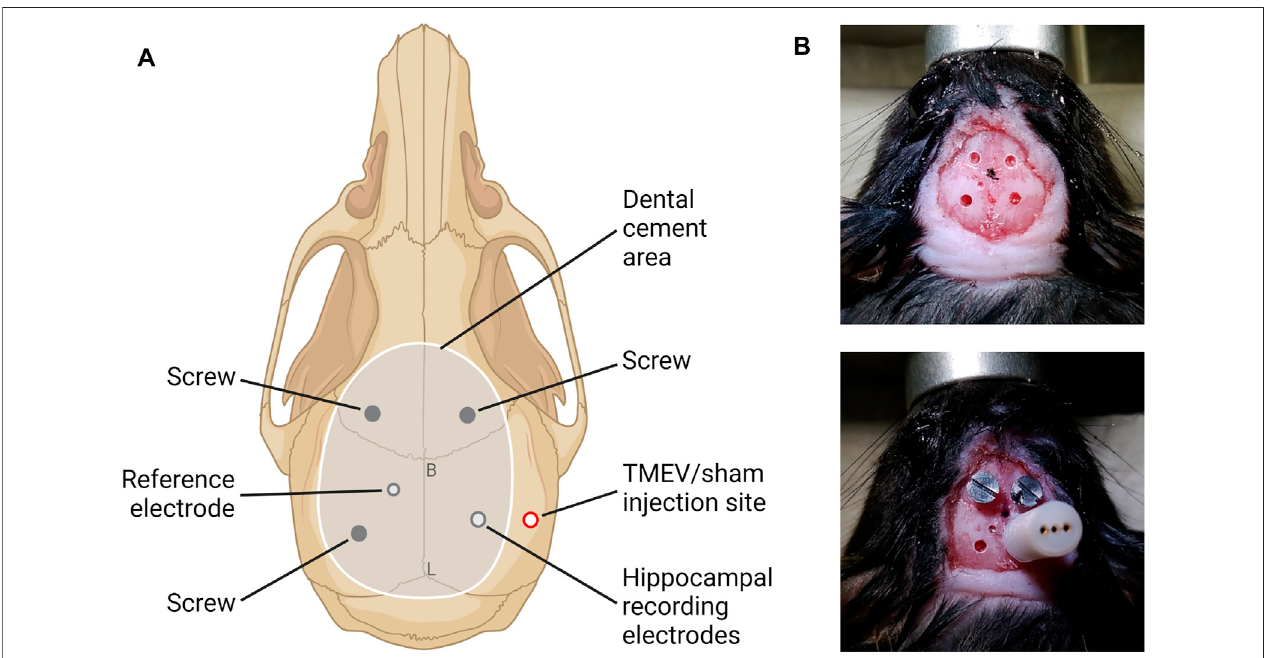
FIGURE 1 | Depiction of the placement of electrodes and the electrodes-anchoring assembly in mice for ECoG. (A) Schematic of the mouse skull showing the locationforelectrodesandanchoringscrewsoverthedorsalsurfaceofskull(B – bregma, L – lambda).ThisschematicwascreatedwithBioRender.com. (B) Photographs of the mouse head captured during surgical procedure showing the holes drilled in skull (upper panel) and the implant of electrodes and anterior screws (lower panel).